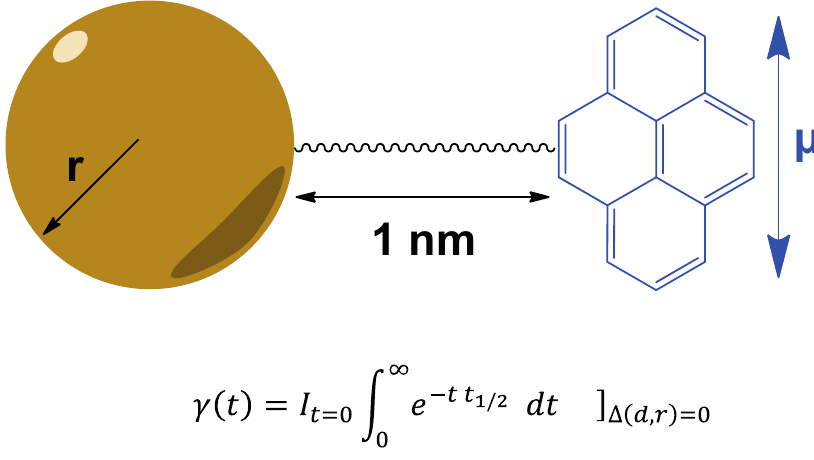
Figure 7. Small gold particles quench the fluorescence intensity of a nearby chromophore. A small gold particle with the radius r can quench the fluorescence intensity of a chromophore with the magnetic moment µ oriented perpendicular to the nanoparticle-chromophore axis of 1 nm according an exponential decay γ (expressed as function of time with r and d being held constant (see text for